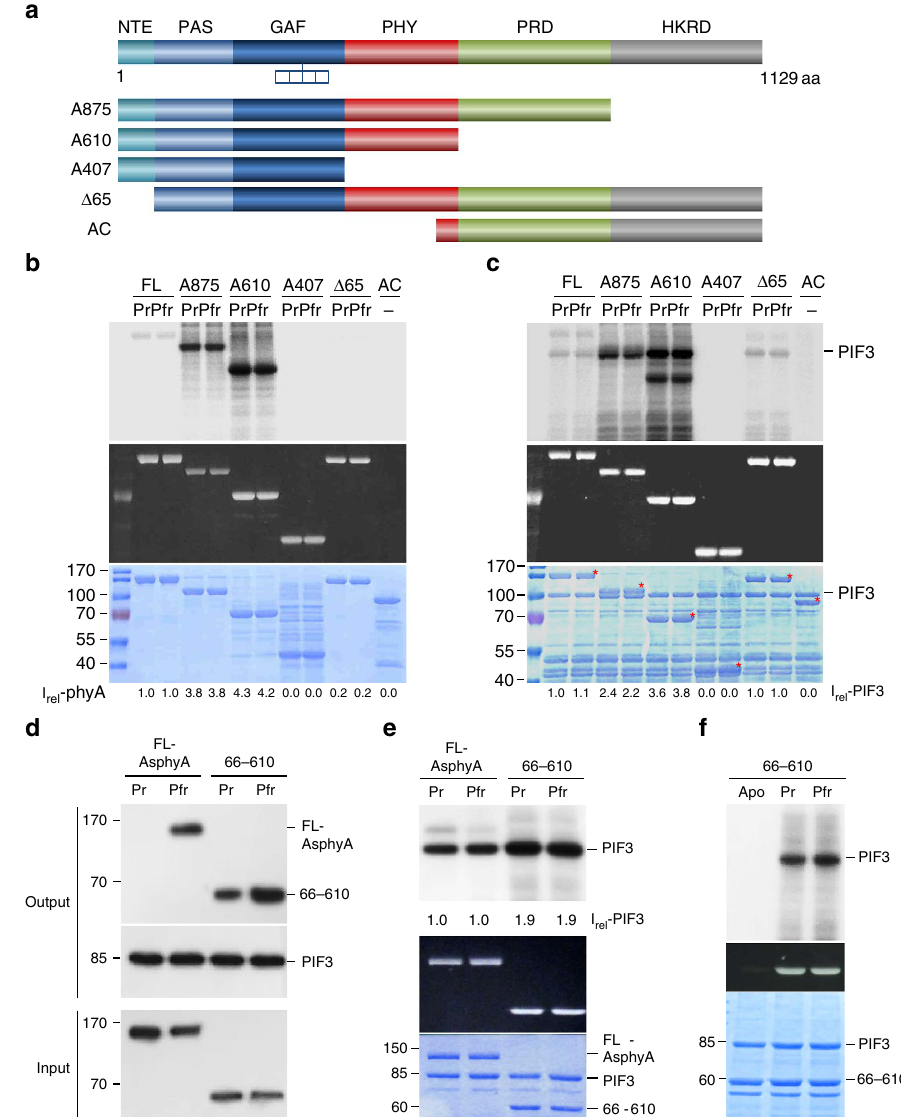
Figure 3 | The proposed protein kinase domain of AsphyA resides in the N-terminal photosensory core composed of PAS-GAF-PHY tri-domain. ( a ) Constructs used for kinase domain mapping of AsphyA. ( b , c ) Autophosphorylation ( b ) and kinase activity ( c ) assays of domain-deletion AsphyA mutants. PIF3 was used as the substrate for the kinase assays. Asterisks on SDS-PAGE in c indicate the corresponding AsphyA protein bands. Intensities (I rel ) of AsphyA autophosphorylation and PIF3 phosphorylation are normalized on the basis of same molar concentrations and expressed relative to the first lanes (that is, Pr forms of FL-AsphyA). ( d ) Protein–protein interaction analysis between PIF3 and the photosensory core. 1.0 m g of full-length AsphyA (FL-AsphyA) or the photosensory core (66–610aa fragment of AsphyA) was incubated with 1.0 m g of GST/strep-fused PIF3. ( e ) Kinase activity assays of the photosensory core using PIF3 as a substrate. 4pmol of full-length AsphyA or the photosensory core (66–610) was reacted with 4pmol of PIF3 for these analyses (that is, B 0.2 m M for each protein). Intensities of PIF3 phosphorylation are expressed relative to lane 1 (Pr form of FL-AsphyA). ( f ) Kinase activity assays of apo- and holo-proteins of the photosensory core. The apo-proteins (Apo) were prepared from P. pastoris cells without addition of chromophore (phycocyanobilin), and the holo-proteins (Pr and Pfr) were prepared by adding phycocyanobilin to purified apo-proteins. Zinc-fluorescence assay (Zinc) was shown to confirm the chromophore-assembled holo-proteins. GAF, cGMP phosphodiesterase/Adenylate cyclase/FhlA domain; NTE, N-terminal extension; PAS, Per/Arnt/Sim domain; PHY, phytochrome-specific GAF-related domain; PRD, PAS-related